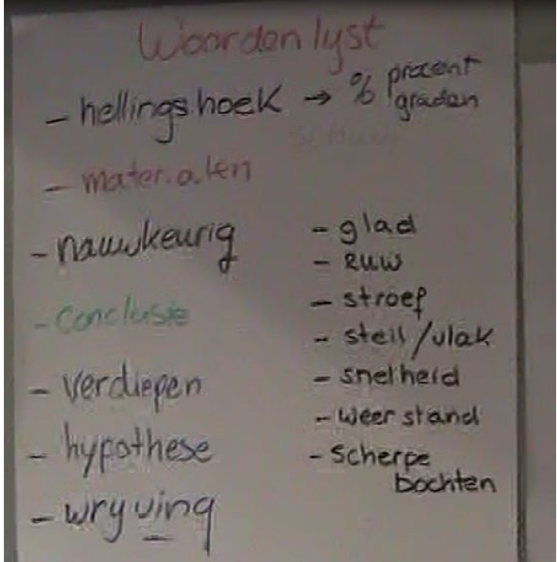
Figure 2. The figure shows the academic word list Emma used as a tool to support verbal reasoning. She frequently added scientific concepts (e.g., friction) to the word